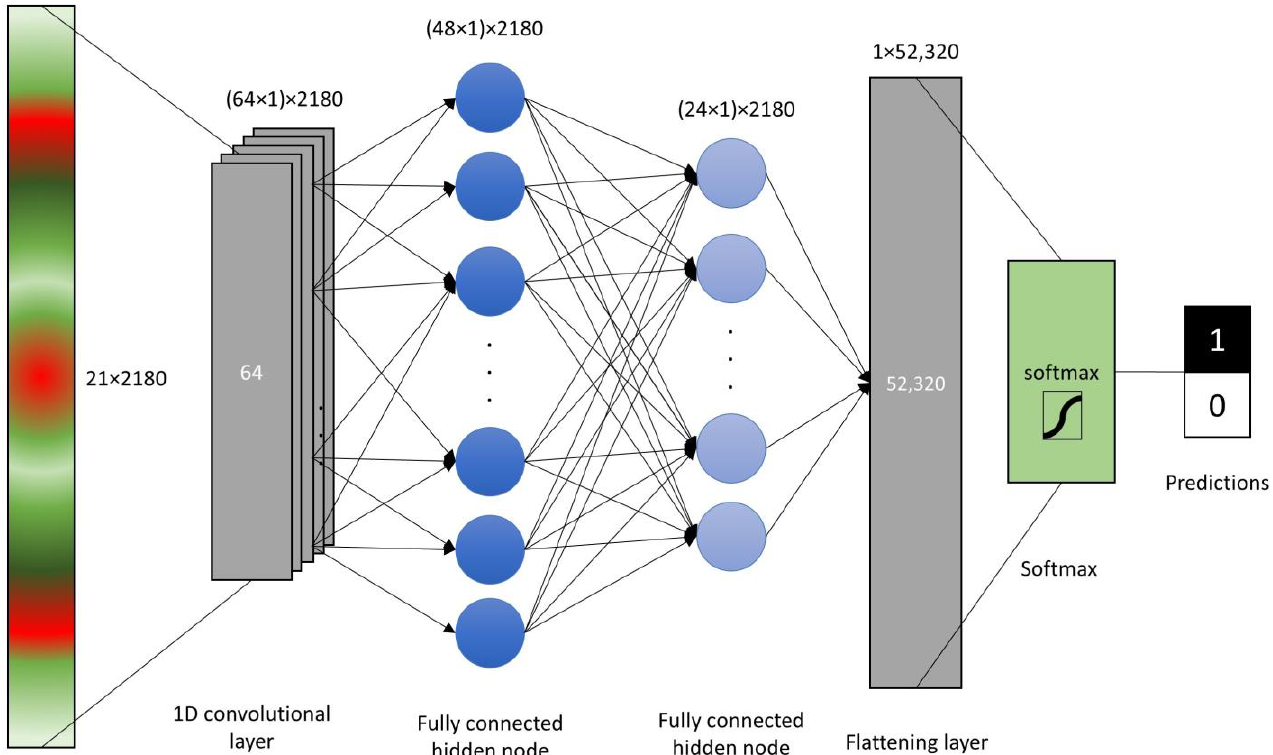
Figure 2. Schematic representation of the convolutional neural network (CNN) with single convolution layer, 2 hidden fully connected nodes, flattening layer and a softmax function.